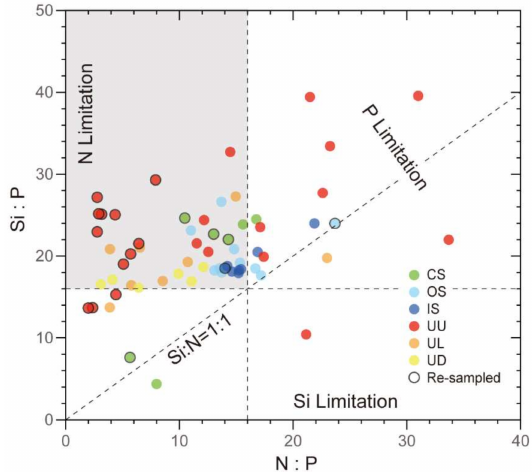
Figure 12. Si:N:P ratios of all stations in this survey. Note that most stations had N limitation, and only one station had Si